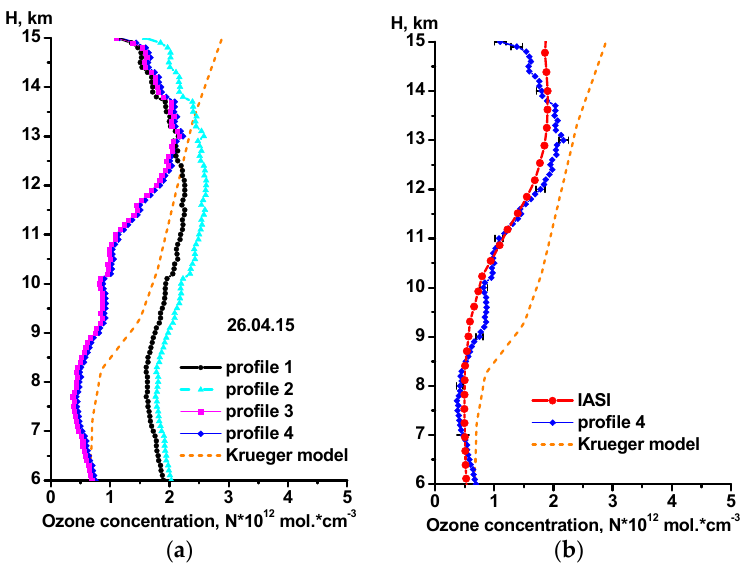
Figure 5. VDO profiles retrieved in comparison with the Kruger model: ozone profile without temperature and aerosol corrections (1), ozone profile with temperature and without aerosol corrections (2), ozone profile without temperature and with aerosol corrections (3), combination of corrections (aerosol and temperature) (4) ( a ); VDO profiles retrieved in comparison with the Kruger model and IASI satellite data ( b ).